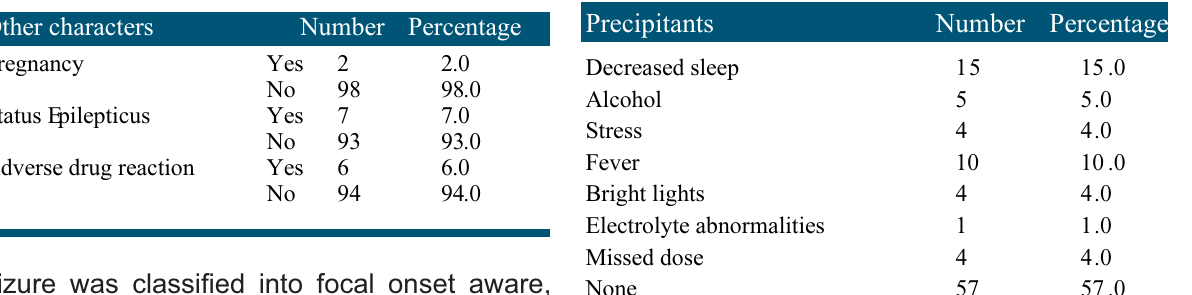
Seizure was classied into focal onset aware,